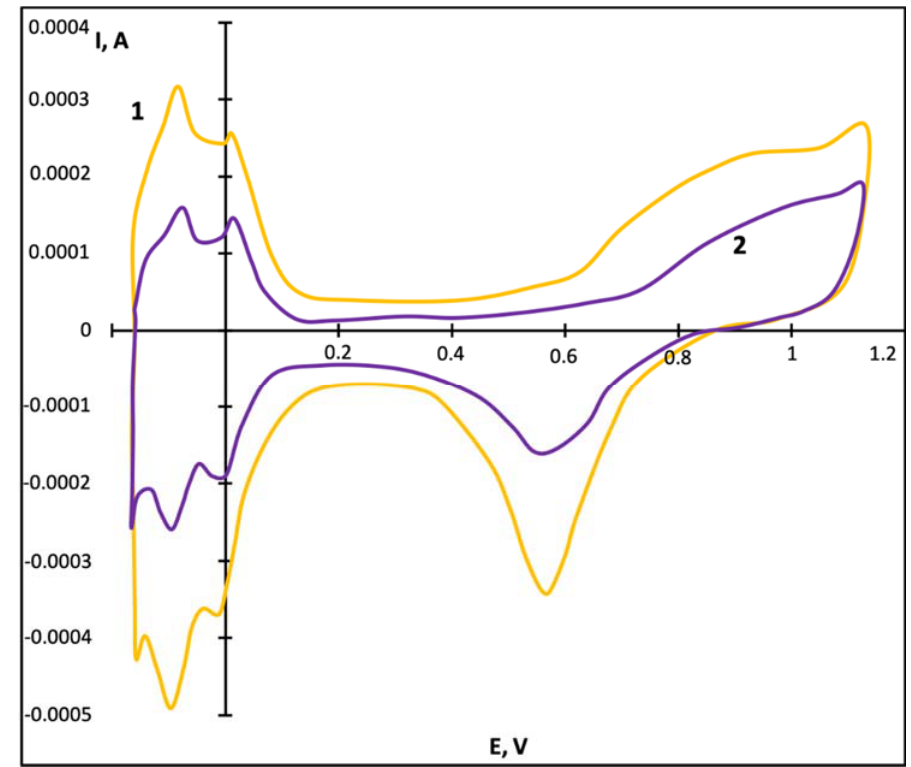
Figure 6. Current ‐ voltage (CV) curves for smooth titanium electrodes with coatings obtained in the DC sputtering regime recorded in 1M solution of sulfuric acid at temperature 25 °C (scan rate 20 mV/s). Curve 1—Pt ‐ C film; curve 2—Pt film.